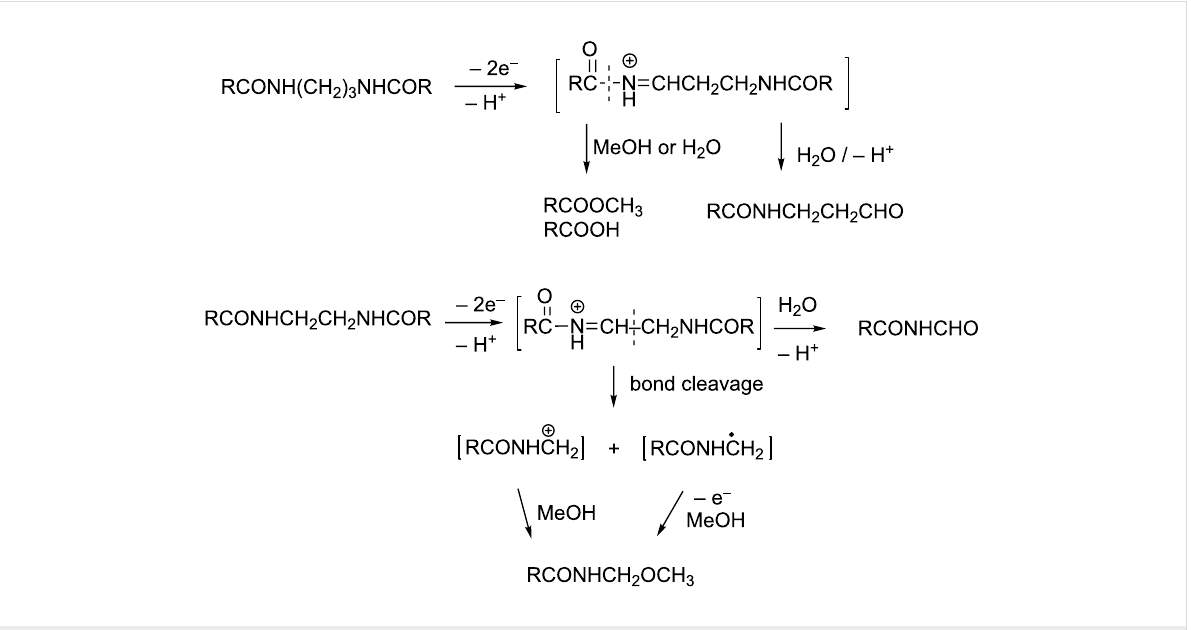
4-methoxybenzoyl chloride. In a typical experiment, 30